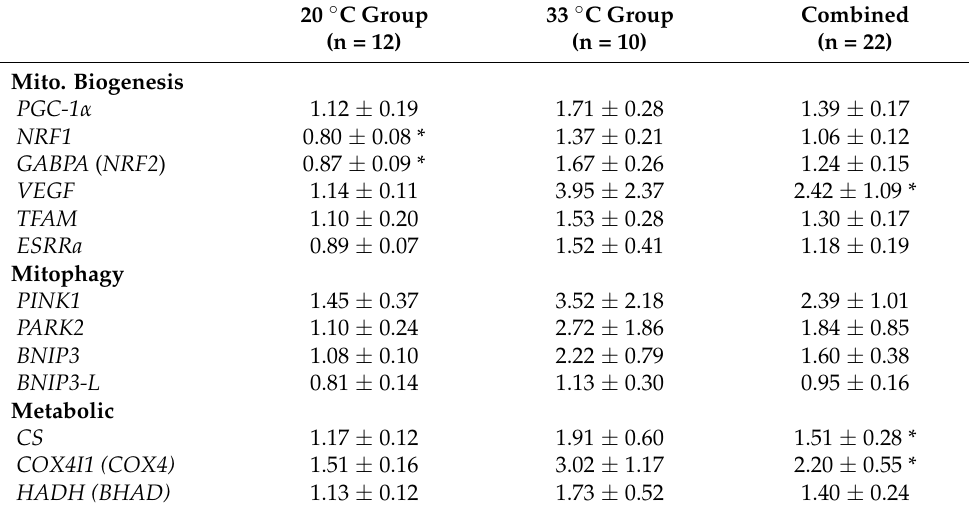
Table 5. Resting mRNA on Day 22 Relative to Day